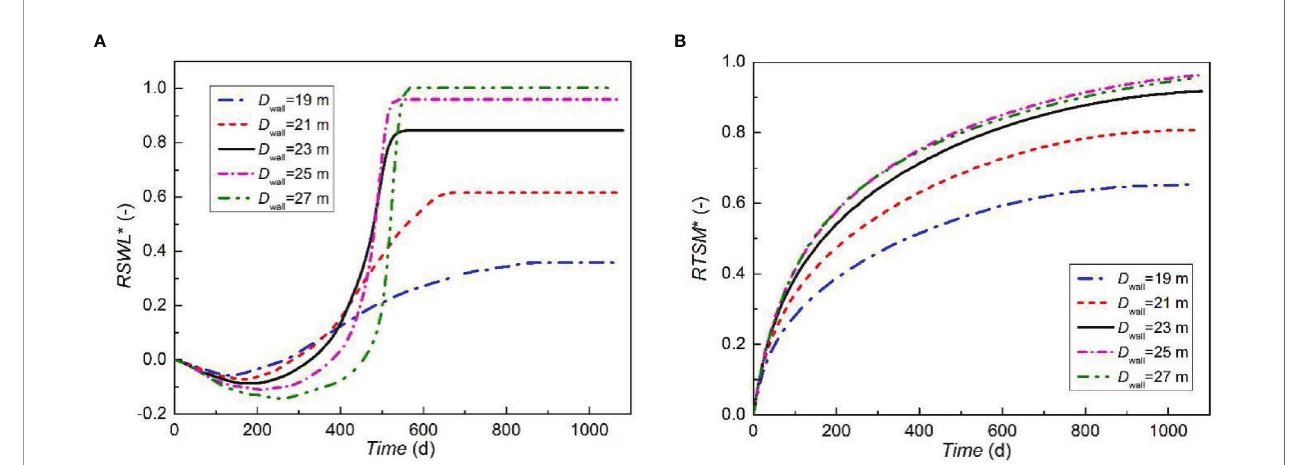
FIGURE 8 | The change of RSWL * (A) and RTSM * (B) over time after the construction of cut-off walls, having 19, 21, 23, 25, 27 m depth,